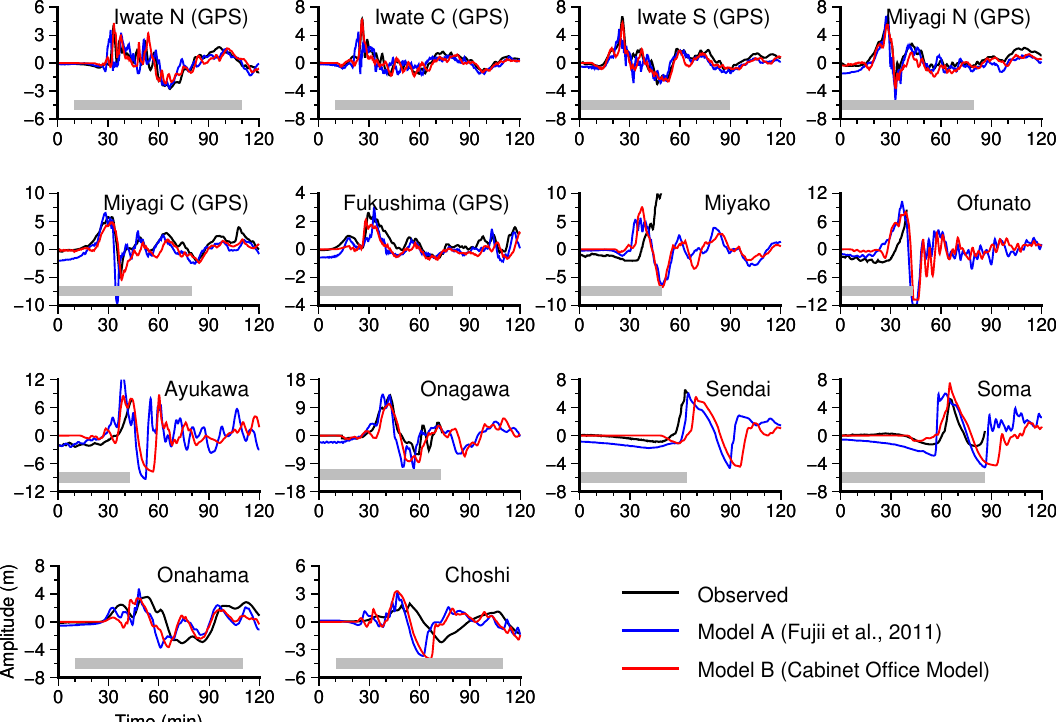
Figure 4. Comparison of recorded (black line) and computed tsunami waveforms as per Fujii et al. [1] (blue line) and the Cabinet Office [9] (red line). The grey bars indicate the time frames used to compute the normalized root-mean-square (NRMS) misfit